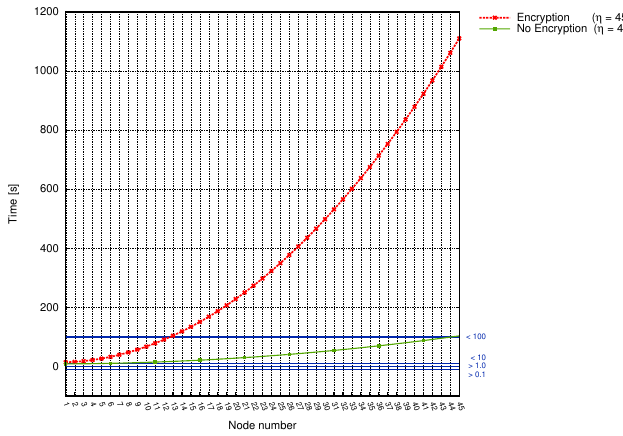
Figure 10. Scenarios 5a,b: correlation between the sink number, time and power grid disturbance time frames (encryption/no